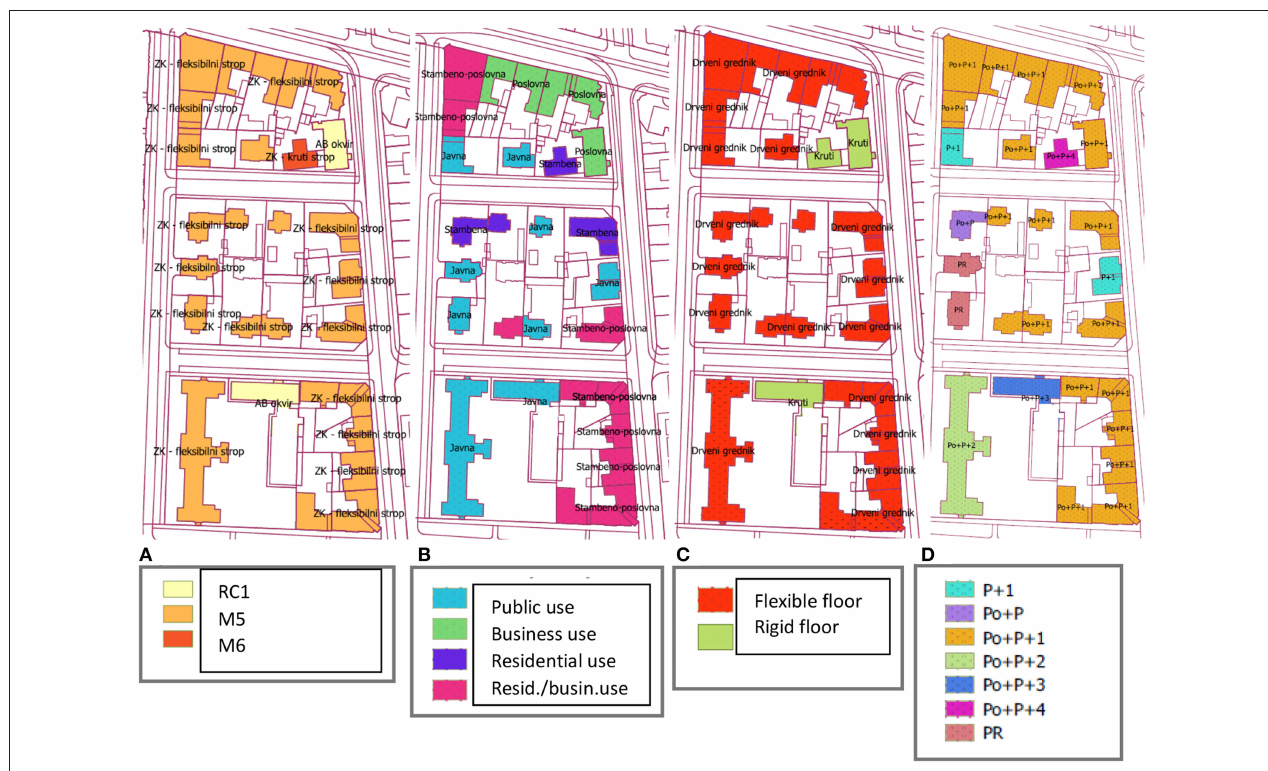
FIGURE 7 | Visualization of (A) Structural System, (B) Usage, (C) Floor Type, and (D) Floor Number, using QGIS Application.